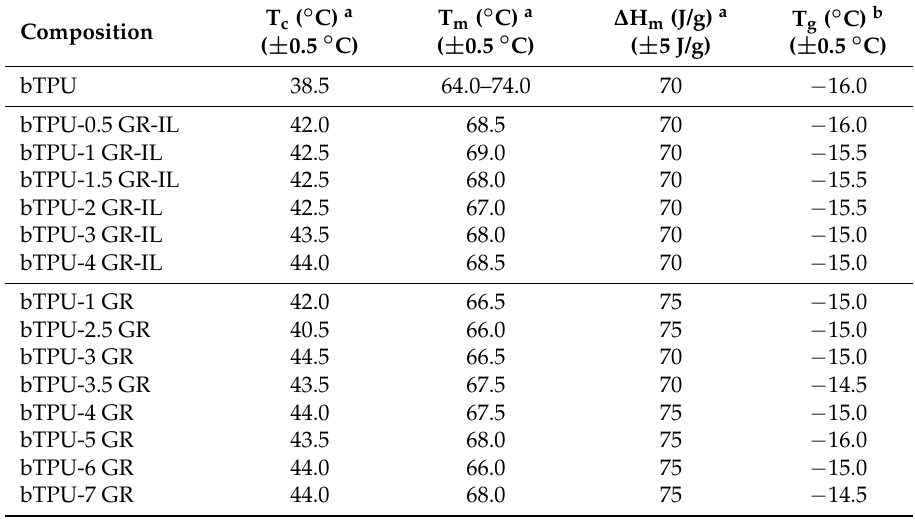
Figure 8. Cooling ( a ) and second heating ( b ) thermograms of the bTPU/GR-IL NCs. Table 3. The crystallization temperature (T c ), melting temperature (T m ), melting enthalpy ( ∆ H m ), and glass transition temperature (T g ) of the bTPU